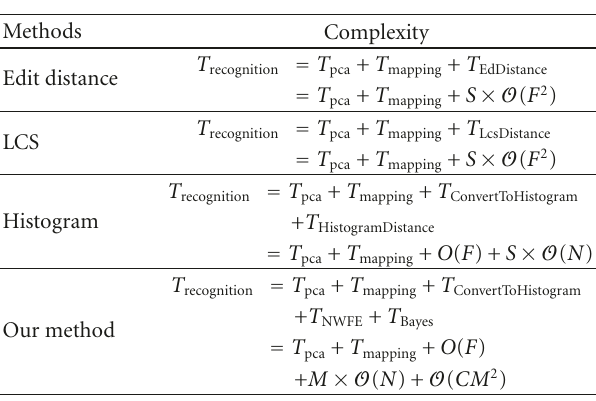
Table 6: Complexity analysis of recognition